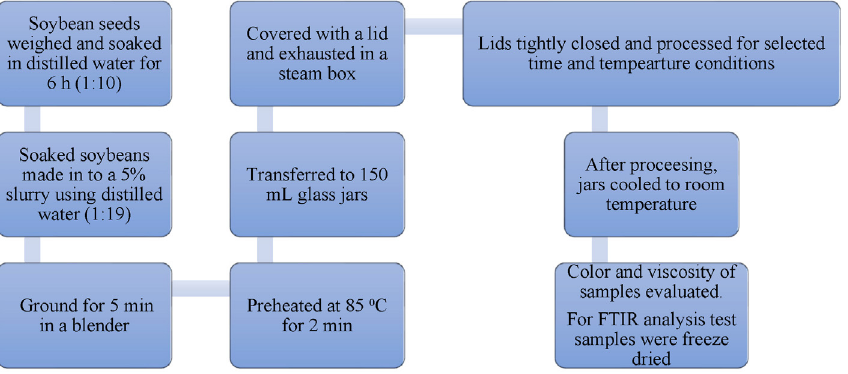
Figure 1. Sample preparation flowchart of soy slurry.